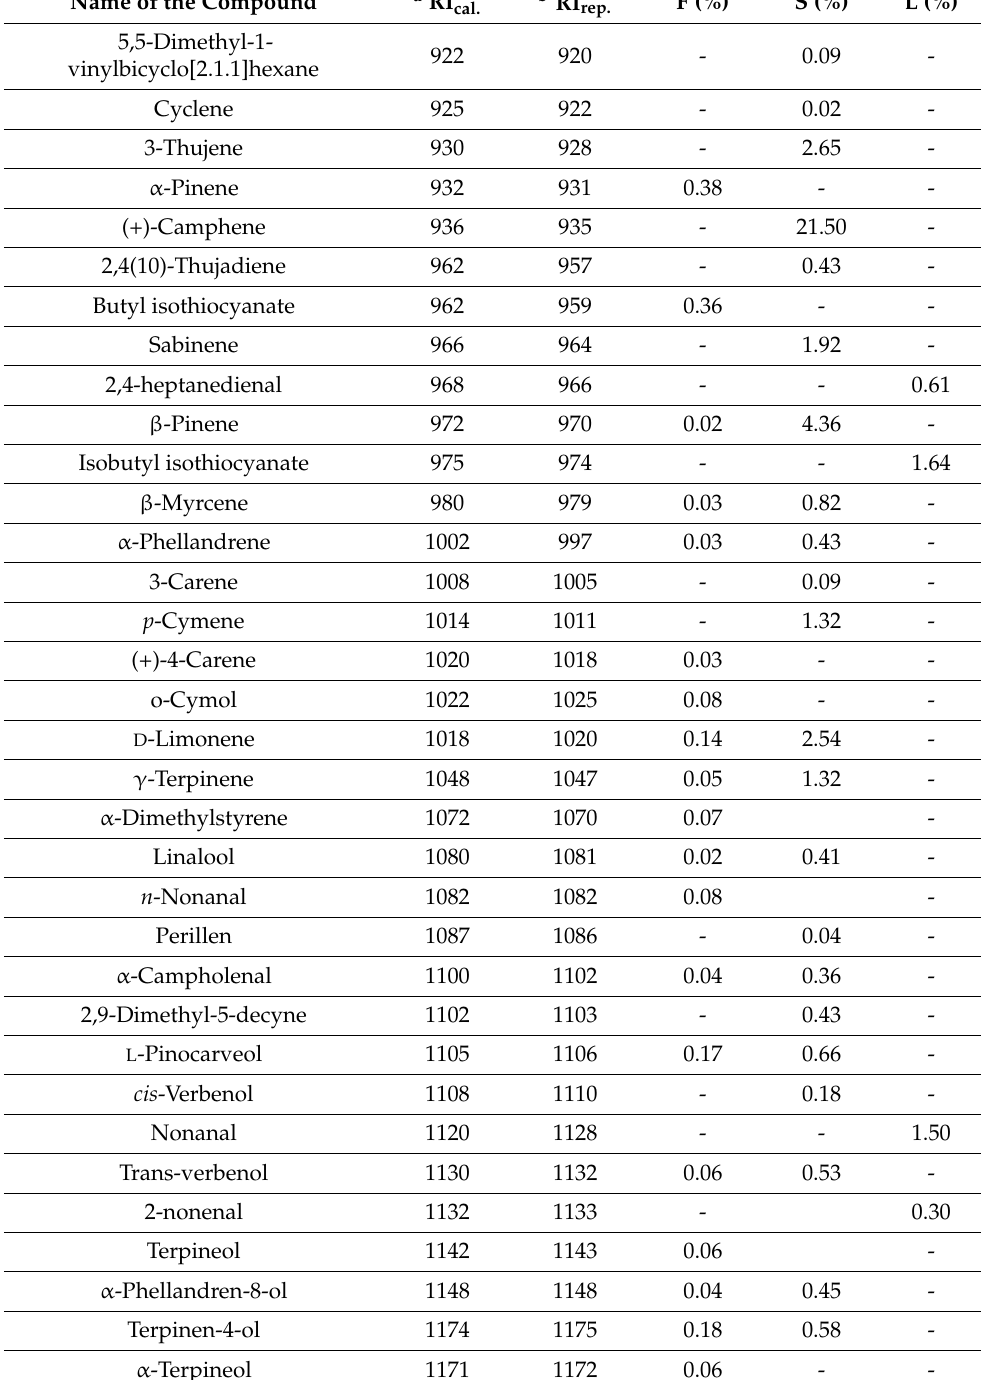
Table 1. The GC-MS-based identified compounds in flowers (F), stem (S), and leaves (L) of O. arabicus . Name of the